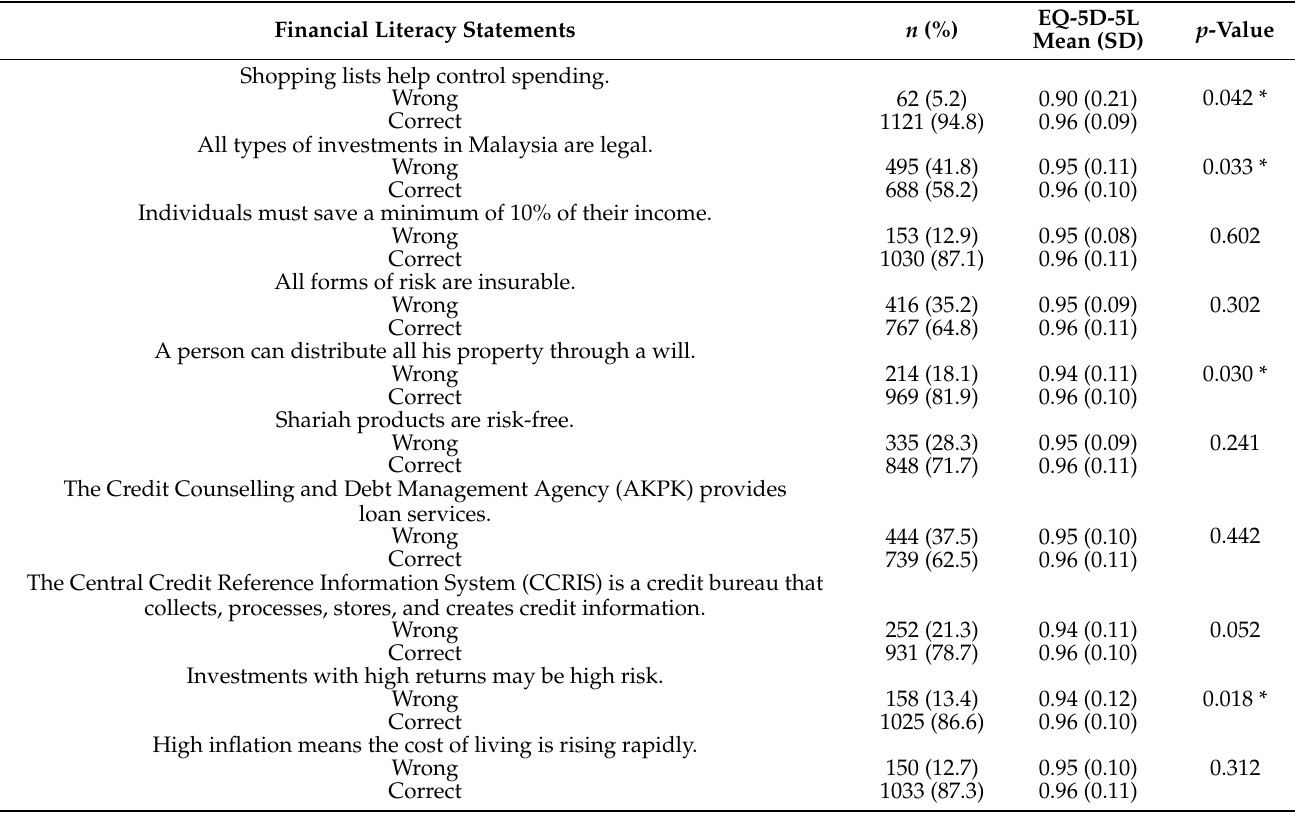
Table 2. Characteristics of Financial Literacy of productive B40 respondents based on HRQOL ( n =